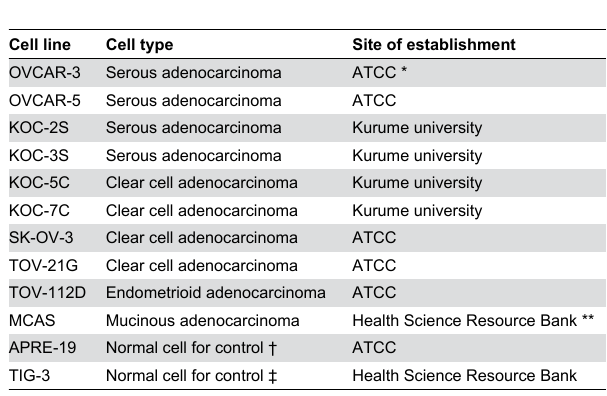
Table 1. Types of Cell Lines and Sites of